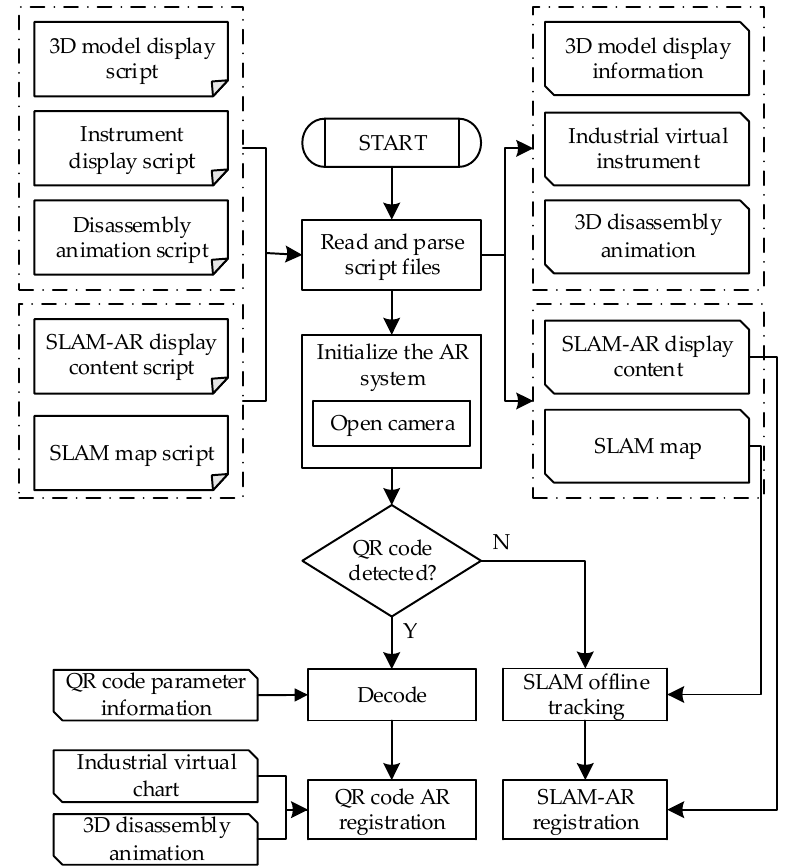
Figure 8. The flow chart of the script parsing and AR display